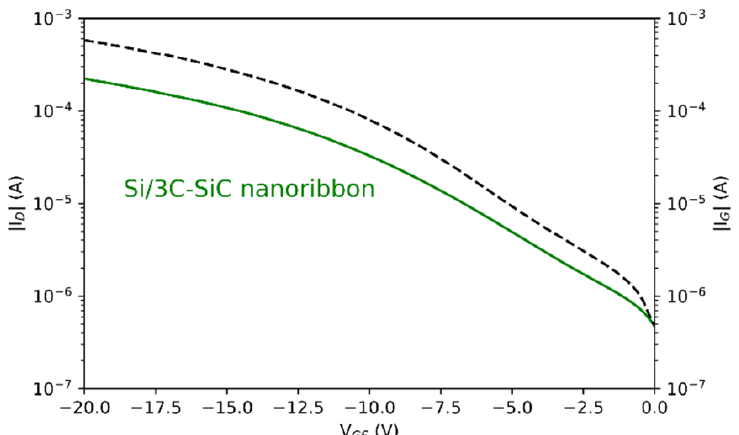
Figure 13. Transfer characteristics of backgated core-shell Si/ a -SiC nanoribbon devices: a -SiC-coated SOI device resulting in thin SiC shell. Drain current plotted with solid line and gate current with dashed line [43].